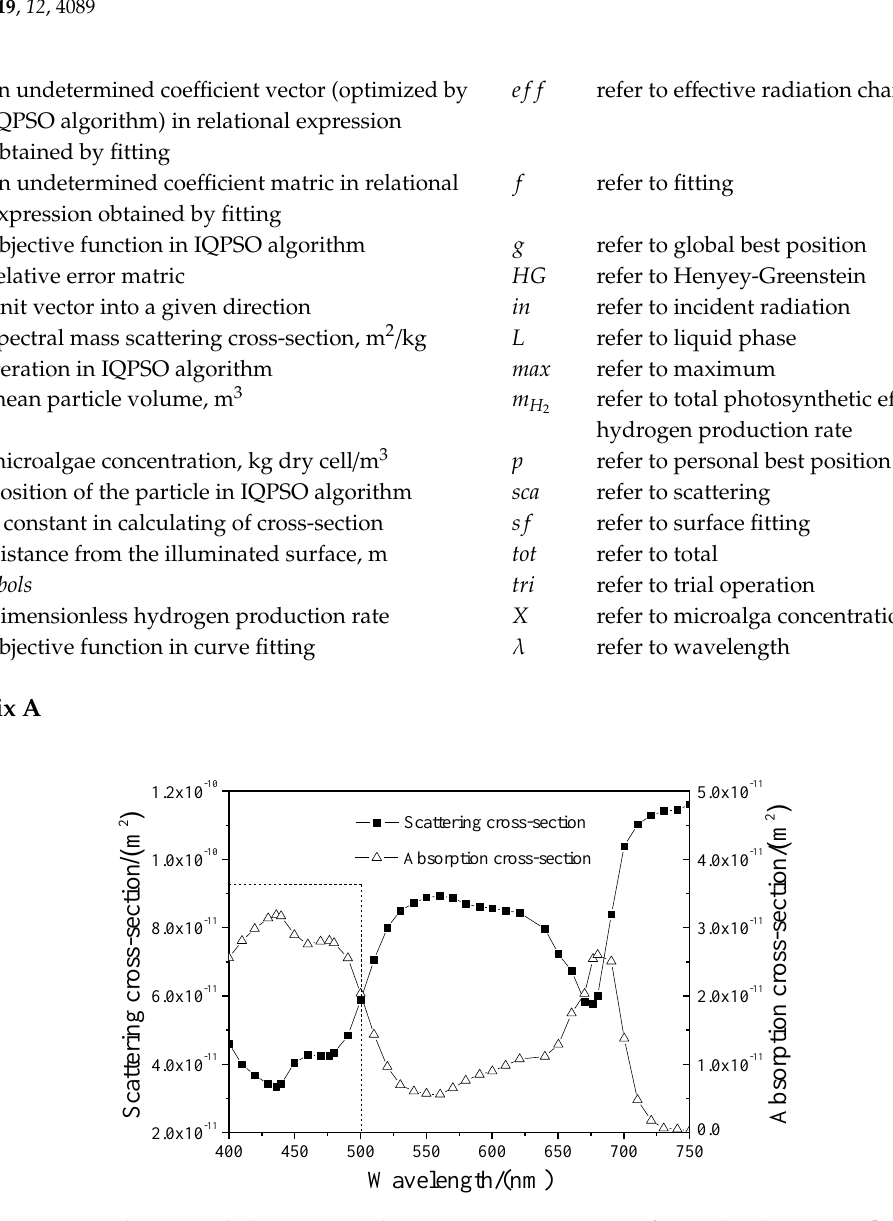
Figure A2. The spectral absorption coefficient of water [20].